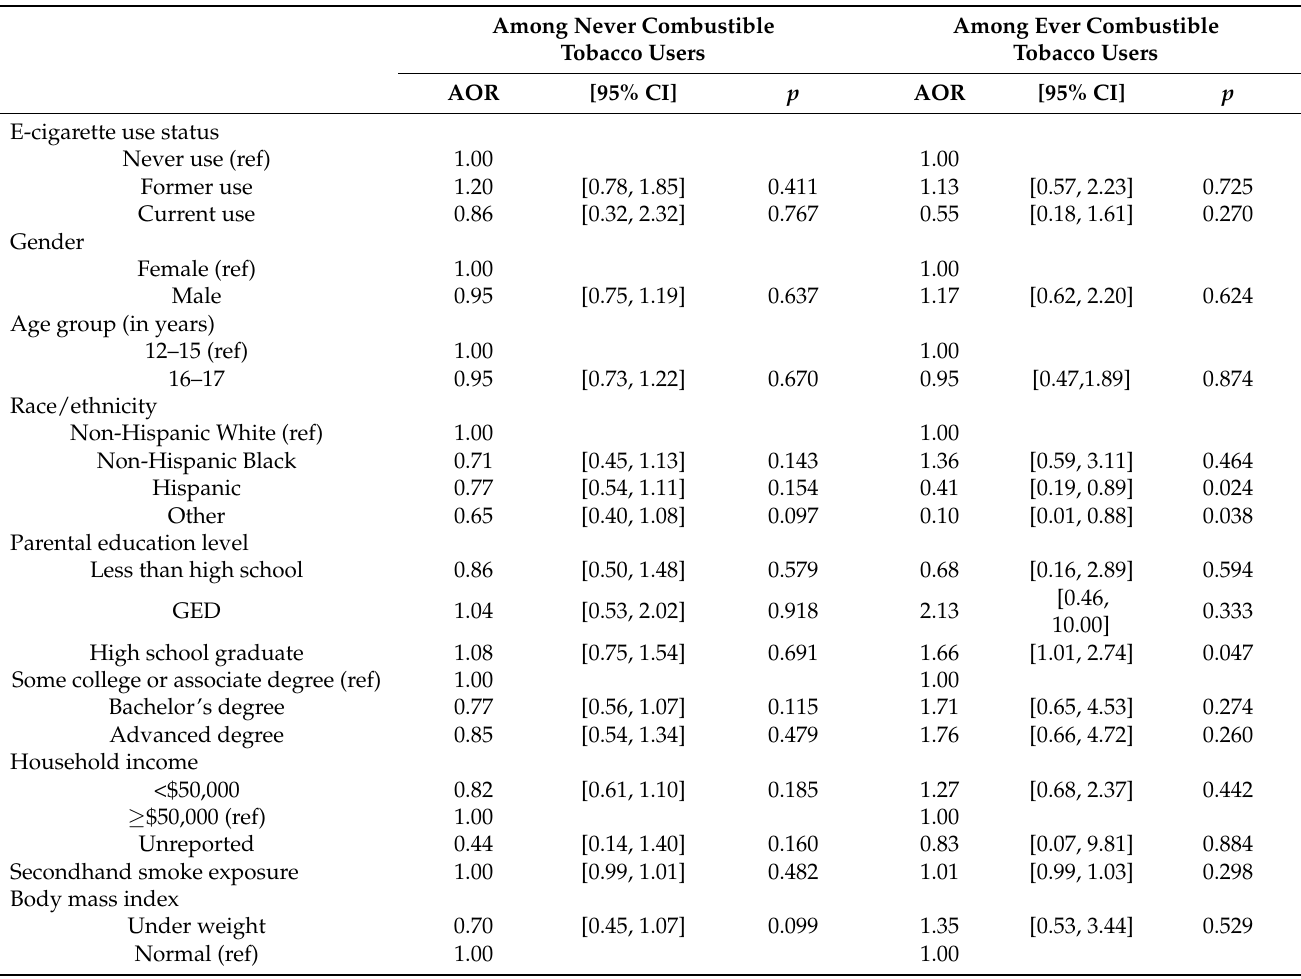
Table 2. Association between baseline e-cigarette use and functionally important respiratory symptom index of ≥ 2 at follow-up by combustible tobacco use status among